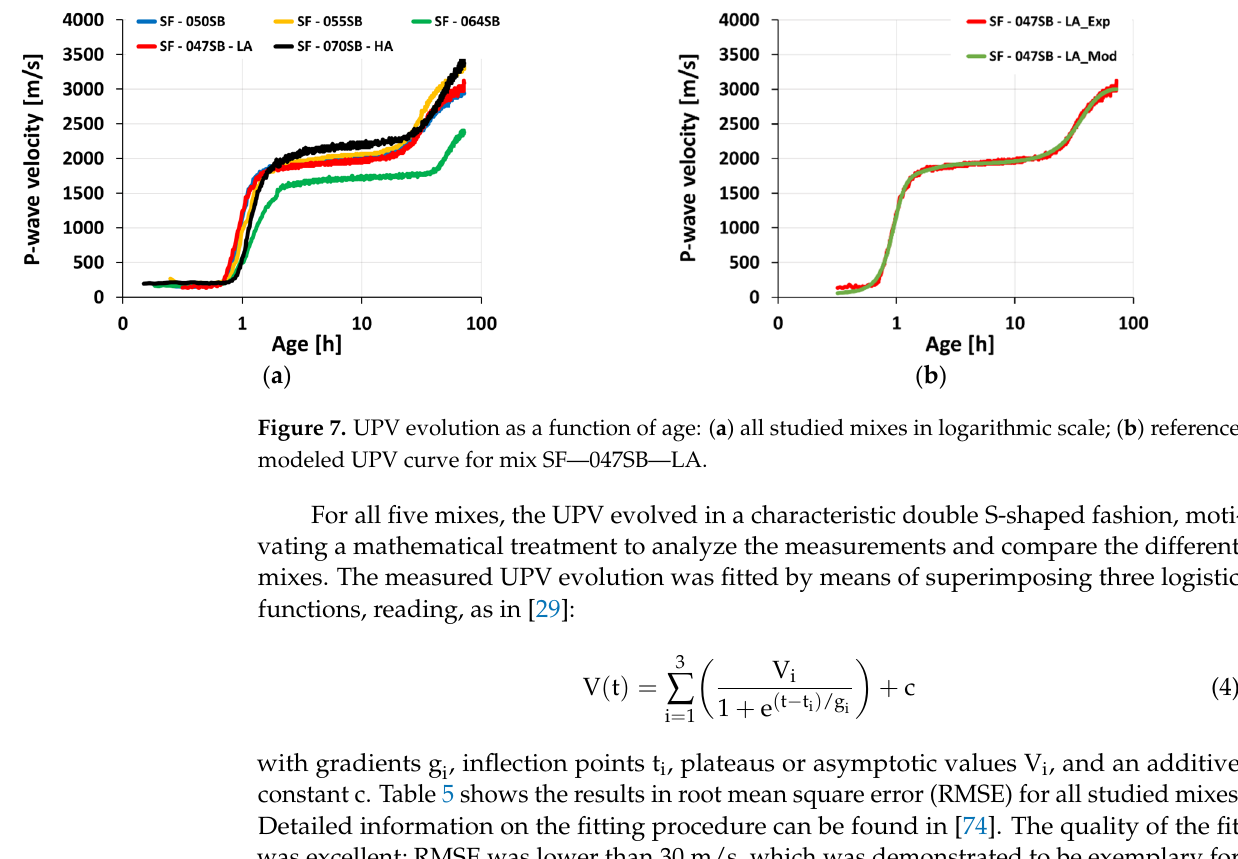
Figure 6. UPV evolution as a function of age.